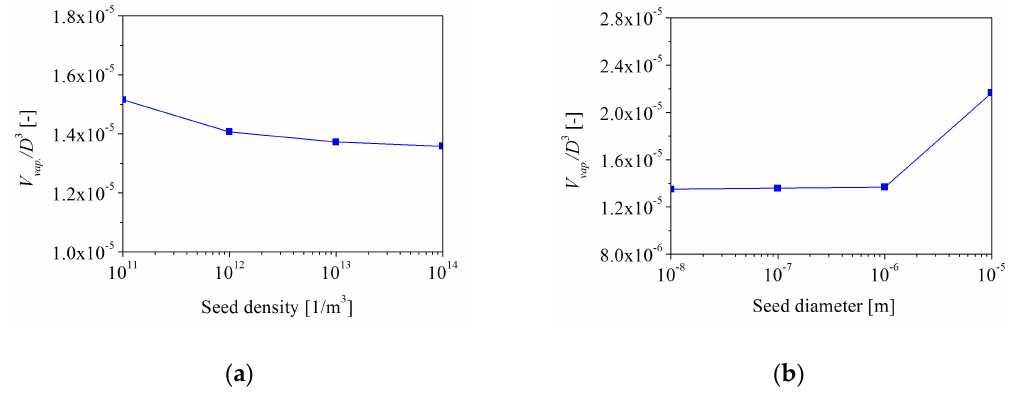
Figure 8. The e ff ect of vapor properties on vapor volume: ( a ) seed density and ( b ) seed Figure 8. The effect of vapor properties on vapor volume: ( a ) seed density and ( b ) seed diameter.